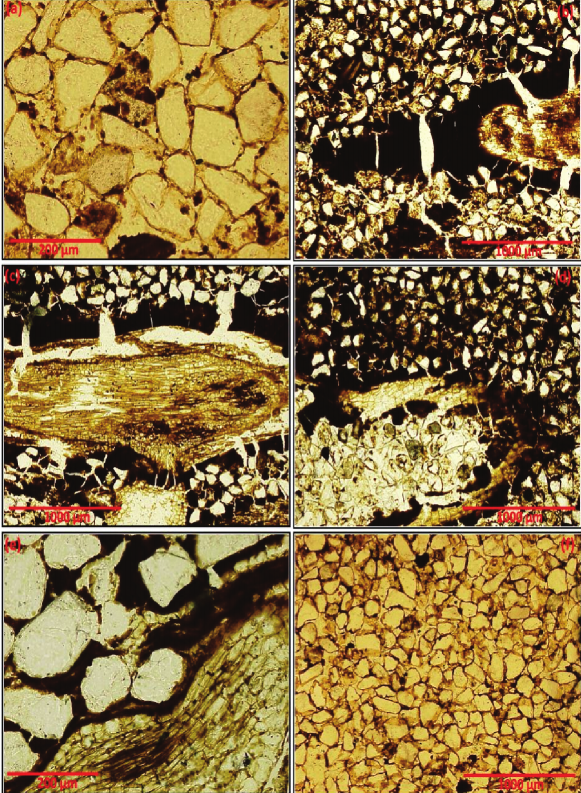
Figura 3. Fotomicrografias mostrando: (a) fábrica representativa do horizonte Bhm, perfil P9 com distribuição relativa g/f 2µm quitônica-gefúrica; (b) resíduo de raiz (estrutura articulada silicosa; P9; Bhm). Em maior aumento, observam-se células buliformes nas extremidades meristemáticas e alongadas no restante da estrutura. Maior concentração de carbono orgânico se dá na extremidade meristemática da raiz devido à maior intensidade dos processos vitais da raiz; (c) resíduo de raiz (perfil P9; Bhm), com finos isotrópicos e uniformes em cor e densidade possivelmente relacionados à iluviação de matéria orgânica e deposição no entorno da raiz, favorecidos pela própria atividade radicular; (d) resíduo de raiz com distribuição relativa porfírica ao seu redor e presença de constituintes grossos no seu interior (perfil P9; Bhm); (e) resíduo radicular do perfil P10, horizonte Bh2; distribuição relativa porfírica no seu entorno. Notar células alongadas no interior da estrutura articulada silicosa e buliformes nas extremidades (f) fábrica representativa do horizonte Bh2 do perfil P10; distribuição relativa g/f 2µm quitônica com tendências locais